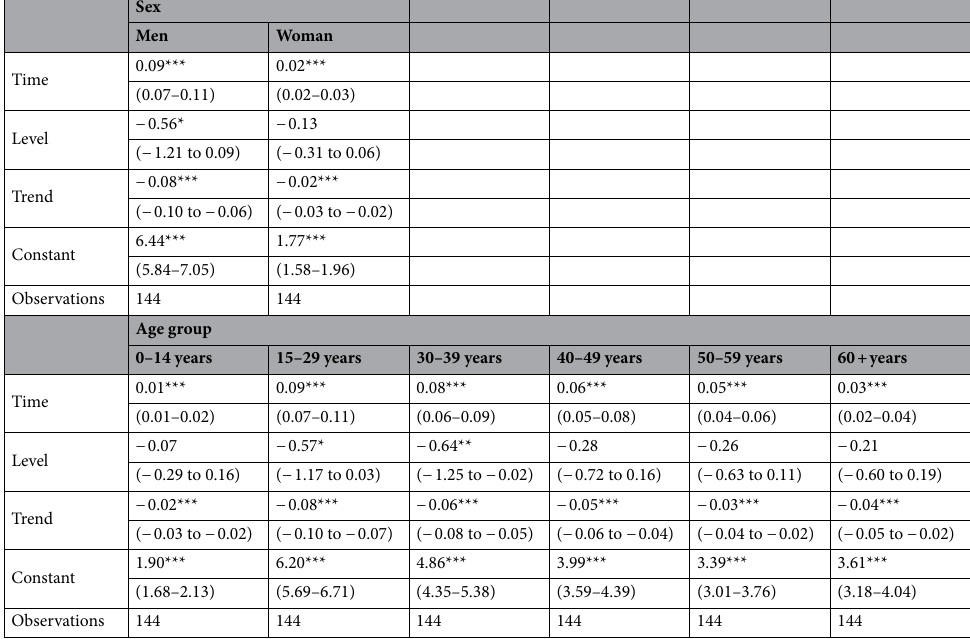
Table 5. Results from the interrupted time series by sex and age group, Brazil, 2008–2019. 95% CIs in parentheses. *** p < 0.01, ** p < 0.05, * p <